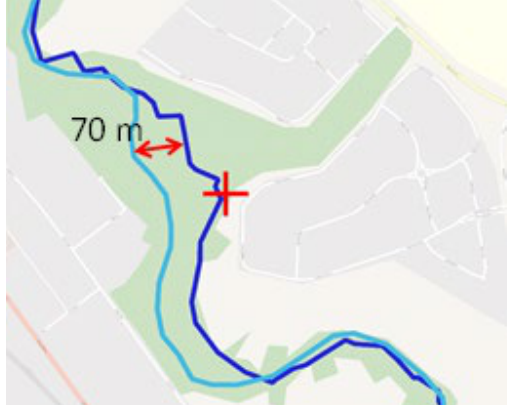
Figure 9: Area of significant change of the Canning River. In dark blue the location of the river in 1841; in light blue the location of the river today (OSM).